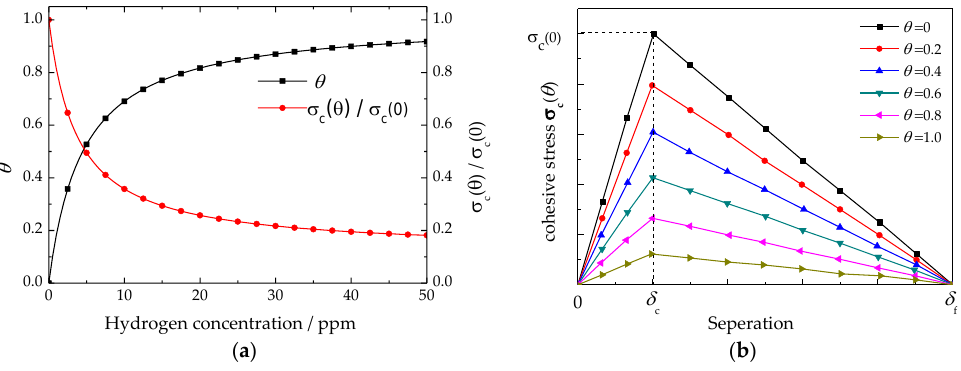
Figure 6. Variation of cohesive model parameters vs. hydrogen content: ( a ) hydrogen coverage and critical cohesive stress; ( b ) bilinear cohesive zone model.